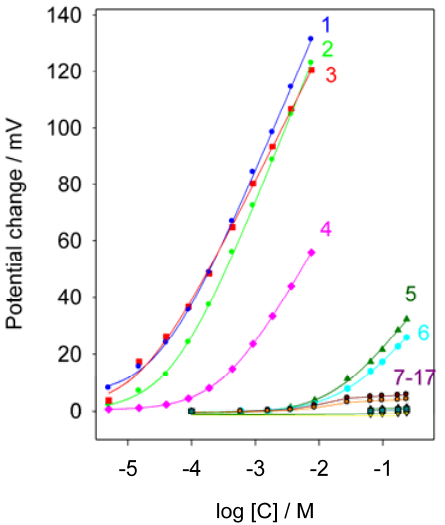
Figure 6. Calibration graph for sulpiride and interferent ions. Curves: 1 ranitidine; 2 sulpiride; 3 ofloxacine; 4 cimetidine; 5 K + ; 6 NH 4+ ; 7 – 17 Ca 2+ , Mg 2+ , glucose, lactose, sucrose, urea, uric acid, hipuric acid, amoxiciline, diclofenac and carbamazepine